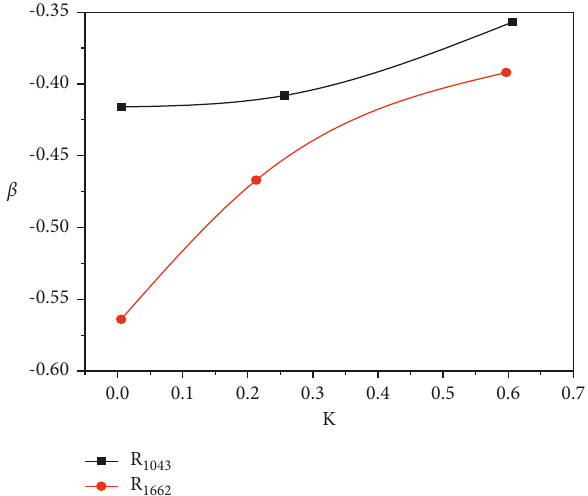
Figure 7: 2-variable ridge trace diagram.